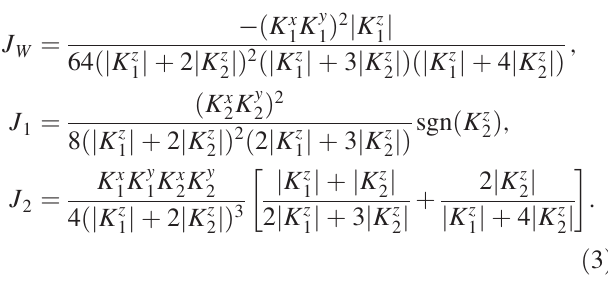
FIG. 5. Top: The three types of virtual processes around the strong-coupling limit r ¼ 0 [35]. Bottom: j J J 2 =r 4 versus ψ . The shaded strips denote the regions where J 2 competes with J 1 and J 2 > 2 j J 1 j